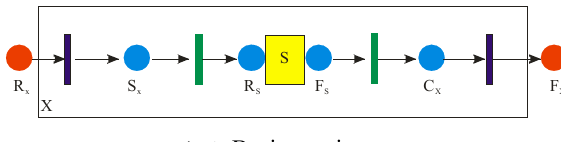
Fig.1. Basic service net